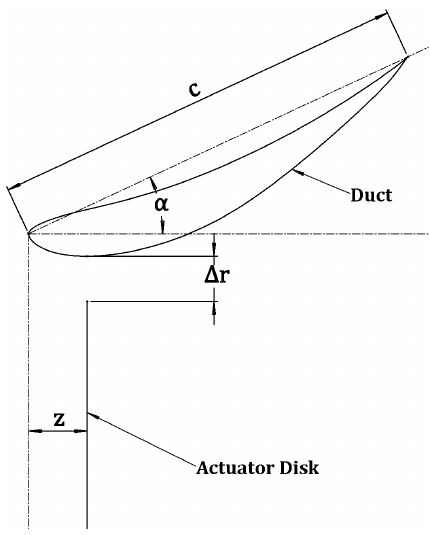
Figure 1. The design